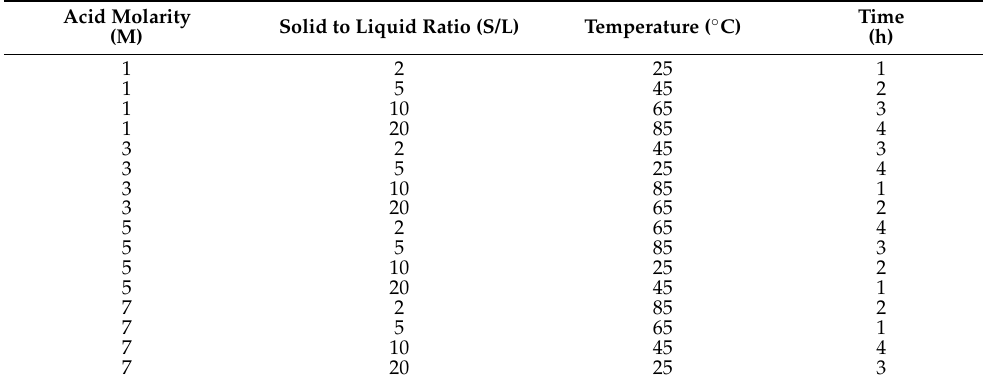
Table 2. The 16 leaching experiments resulted from Taguchi experimental design.